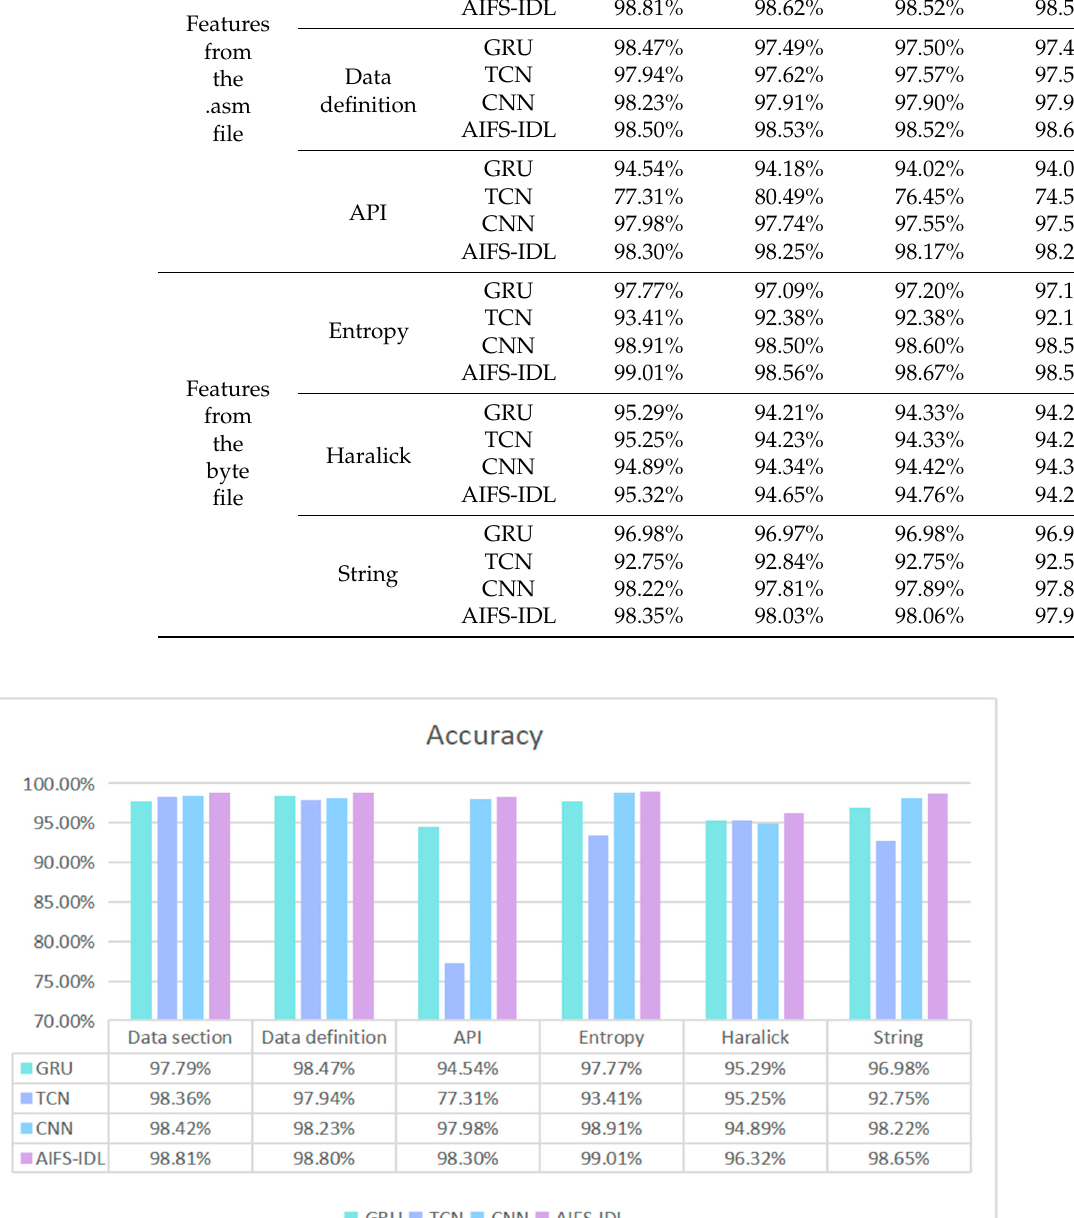
Table 5. Multi-feature fusion experiment results.